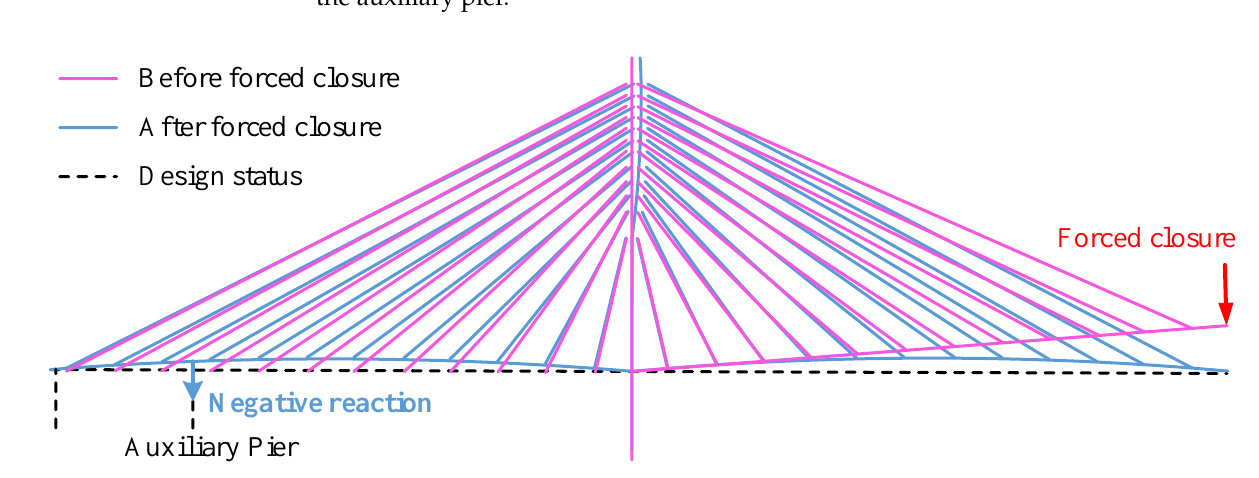
Figure 3. NRRAP caused by forced closure.